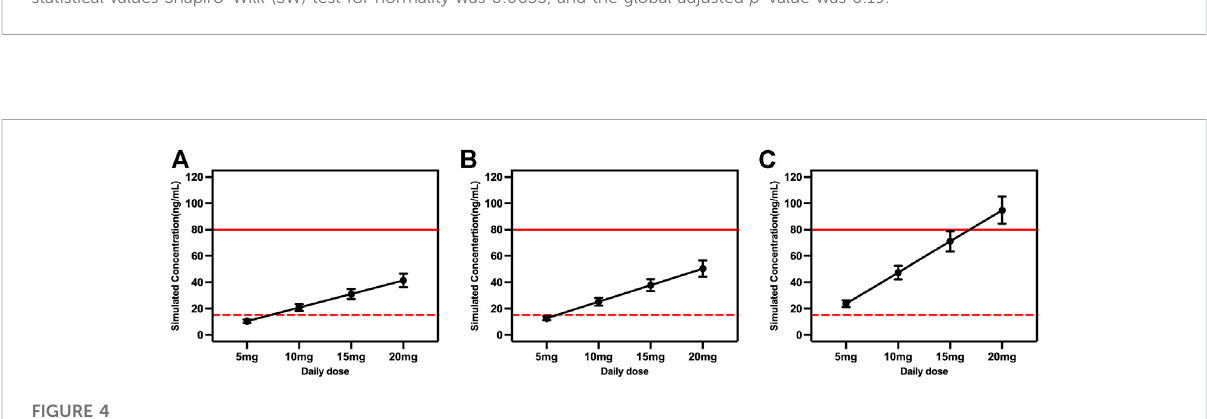
FIGURE 3 NPDE metrics for the PopPK model of escitalopram. The mean of normalized prediction distribution errors (NPDE) was 0.02359, variance was 0.9894, skewness was 0.04414, and kurtosis was 0.3027. The results of t -test and Fisher variance test were 0.664 and 0.911, respectively. The statistical values Shapiro-Wilk (SW) test for normality was 0.0633, and the global adjusted p -value was 0.19.